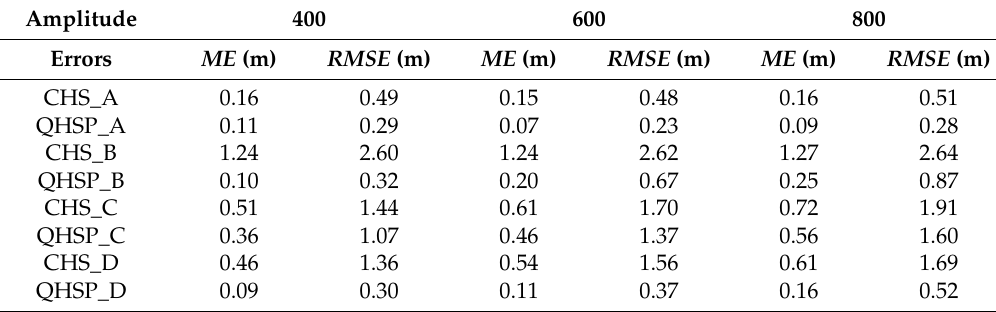
Table 1. Errors of constructed elevation for the sinusoidal rivers with 3